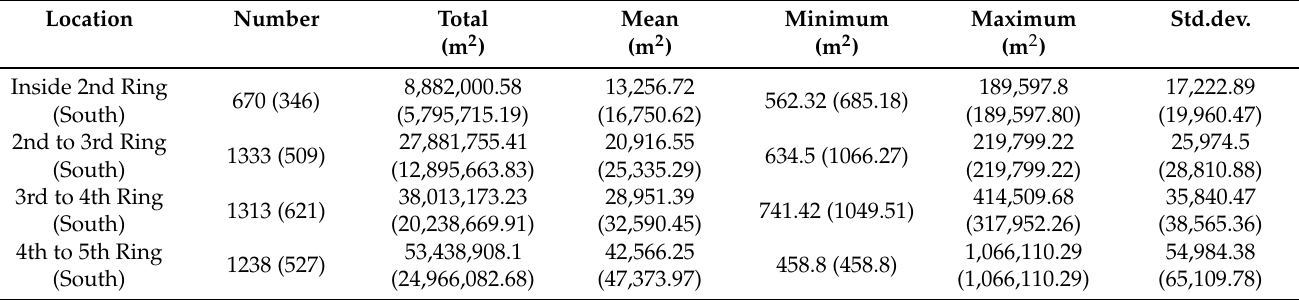
Table 3. Descriptive statistics of the community area in the northern and southern